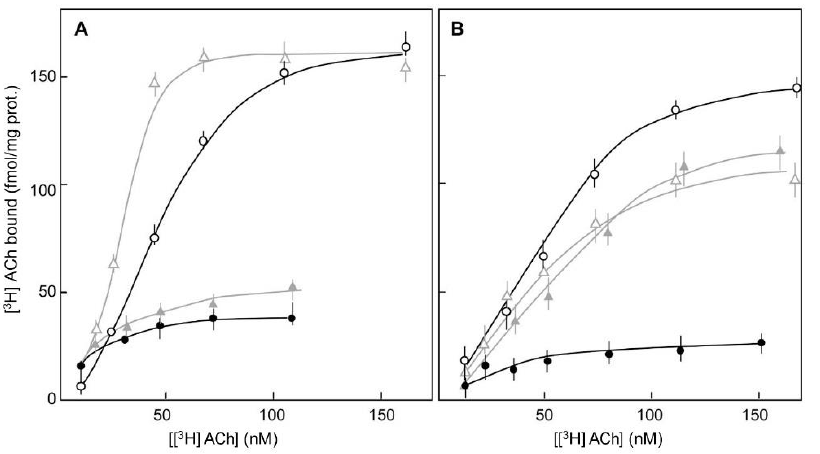
Figure 2. Effects of DPI-enantiomers on the high affinity binding of [ 3 H]acethylcholine ([ 3 H]ACh) to muscarinic receptors in rat brain synaptoneurosomes at resting membrane potential ( , ) and upon depolarization ( , ). [ 3 H]Ach binding measured in untreated synaptoneurosomes (black lines, circles) and in synaptoneurosomes treated (grey lines, triangles) with the S-enantiomer of DPI (5 µM) in the presence of 1 µM TTX ( A ) or with the R-enantiomer of DPI (5 µM) ( B ), are presented. The non-specific binding of [ 3 H]ACh was measured in the presence of 1 µM atropine. (Ref. [12]).